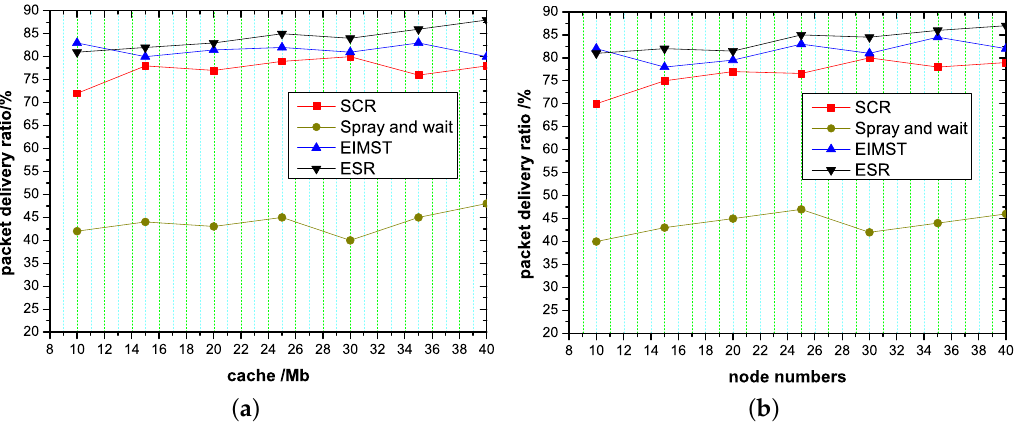
Figure 5. The packet delivery ratio of the ESR algorithm, EIMST algorithm, Spray and wait algorithm and the SCR algorithm at different node cache sizes and numbers of nodes. ( a ) The effect of node cache on packet delivery ratio; ( b ) The effect of node numbers on packet delivery ratio.